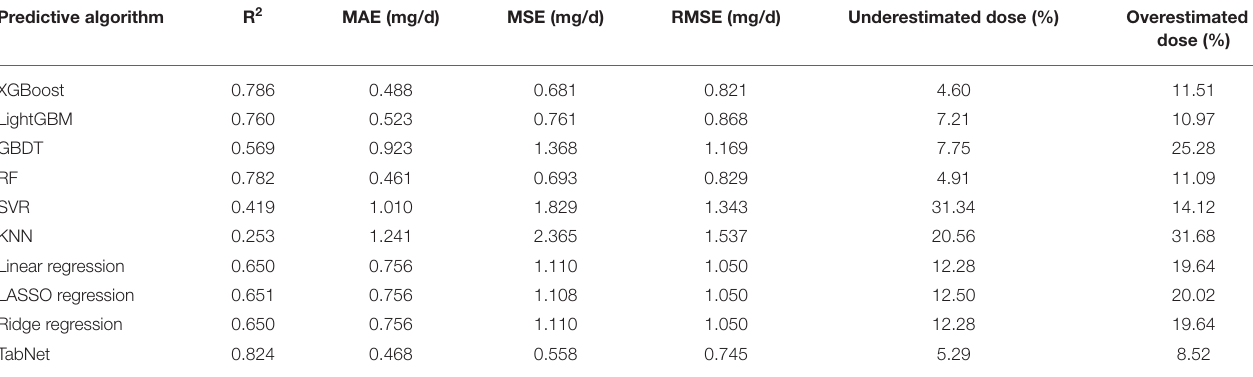
TABLE 3 | R 2 , MAE, MSE, RMSE results, and percentage of overestimated or underestimated dose in the testing cohort of each predictive algorithms. Predictive algorithm